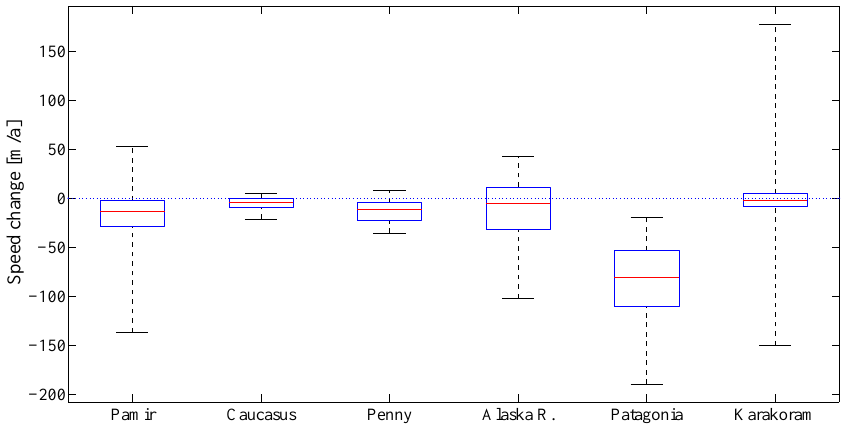
Fig. 4. The speed change of individual glaciers from the first to the second period for the six different regions. The box outline indicates the 25th percentile and the 75th percentile. The dotted bars indicate the range of the speed changes. Negative values indicate lower speeds in the second period. Table 6. Elevation of glaciers and speed change measurements in each area. Area Elevation Elevation Mean elevation Mean elevation glaciers measurements glaciers